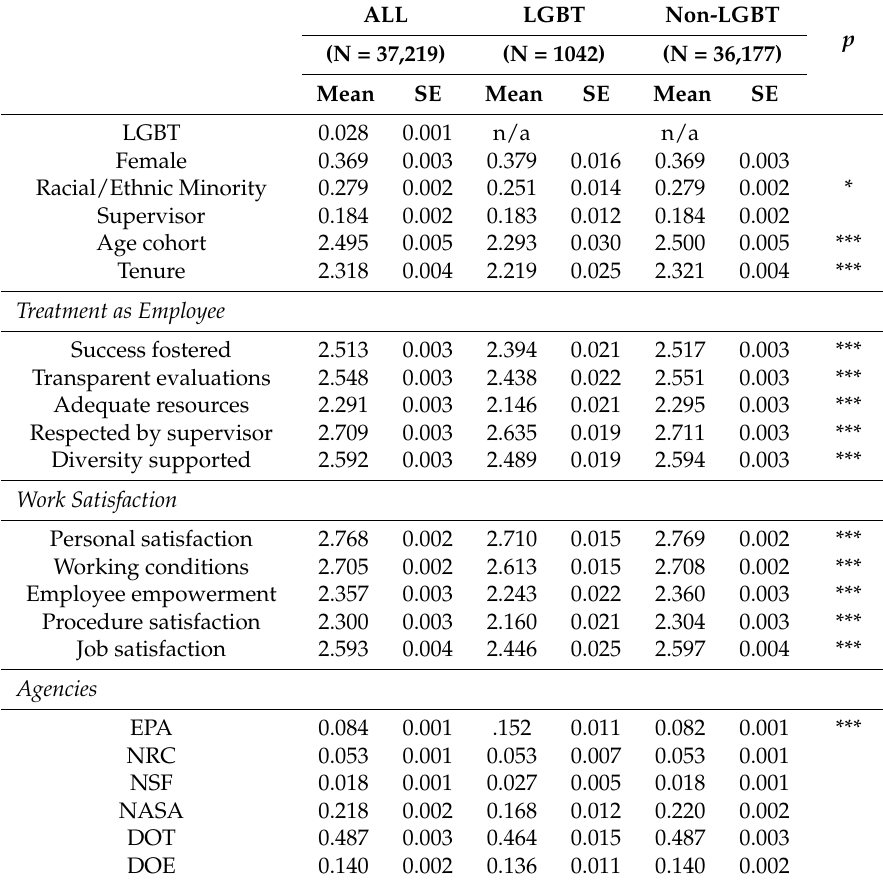
Table 2. Univariate and Bivariate Statistics for LGBT and non-LGBT